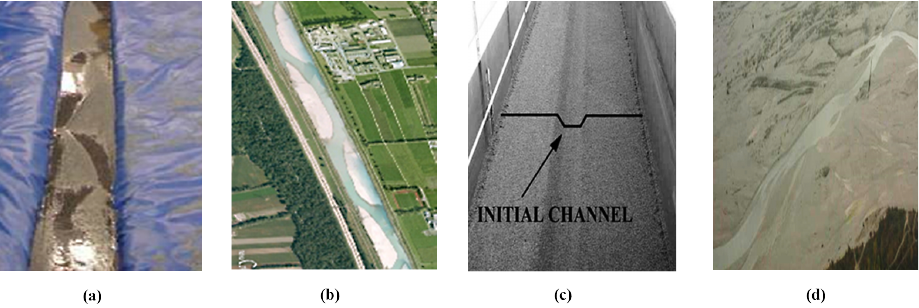
Fig. 1. Examples of channels belonging to the four reference configurations considered in the stability analysis. Each class presents different combinations of discharge and width unsteadiness. More in detail: (a) constant discharge and width (courtesy of Grecia A. Garcia Lugo); (b) variable discharge and fixed width, a reach of the Alpine Rhine in Switzerland; (c) erodible channel with unsteady width and constant discharge; (d) natural, laterally unconfined channel with unsteady width and discharge, Tagliamento River (NE